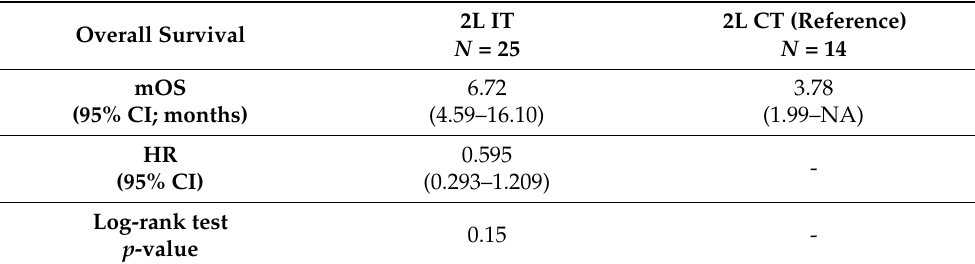
Table A6. Survival outcomes from start date of therapy for second-line palliative immunotherapy and